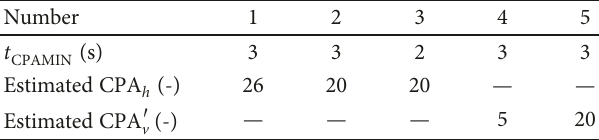
Table 7: Selected threshold combinations.